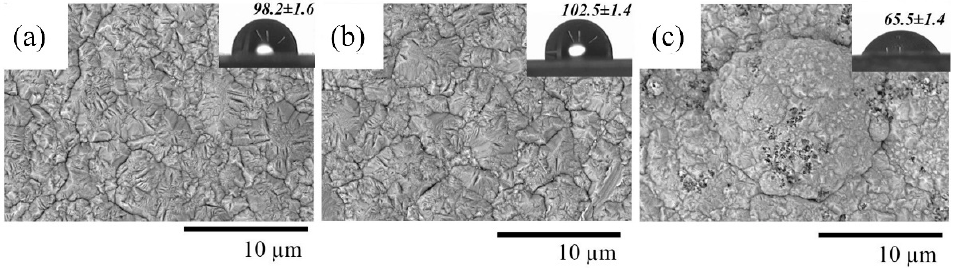
Figure 3. SEM images of Ni ( a ), Ni-CeO 2 ( b ), and Ni-TiO 2 ( c ) coatings. Insets show images of surface contact angle measurements. The contact angle of steel substrate was 79.9 ± 1.0°. Table 4. Composition of nickel and composite nickel-based coatings based on the results of EDX analysis. Element,